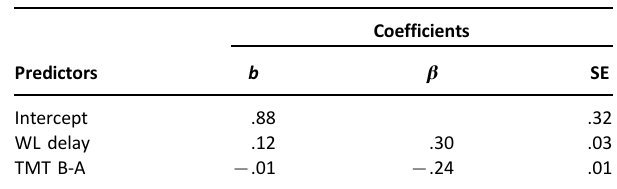
Table 3. Results of the best subset linear regression